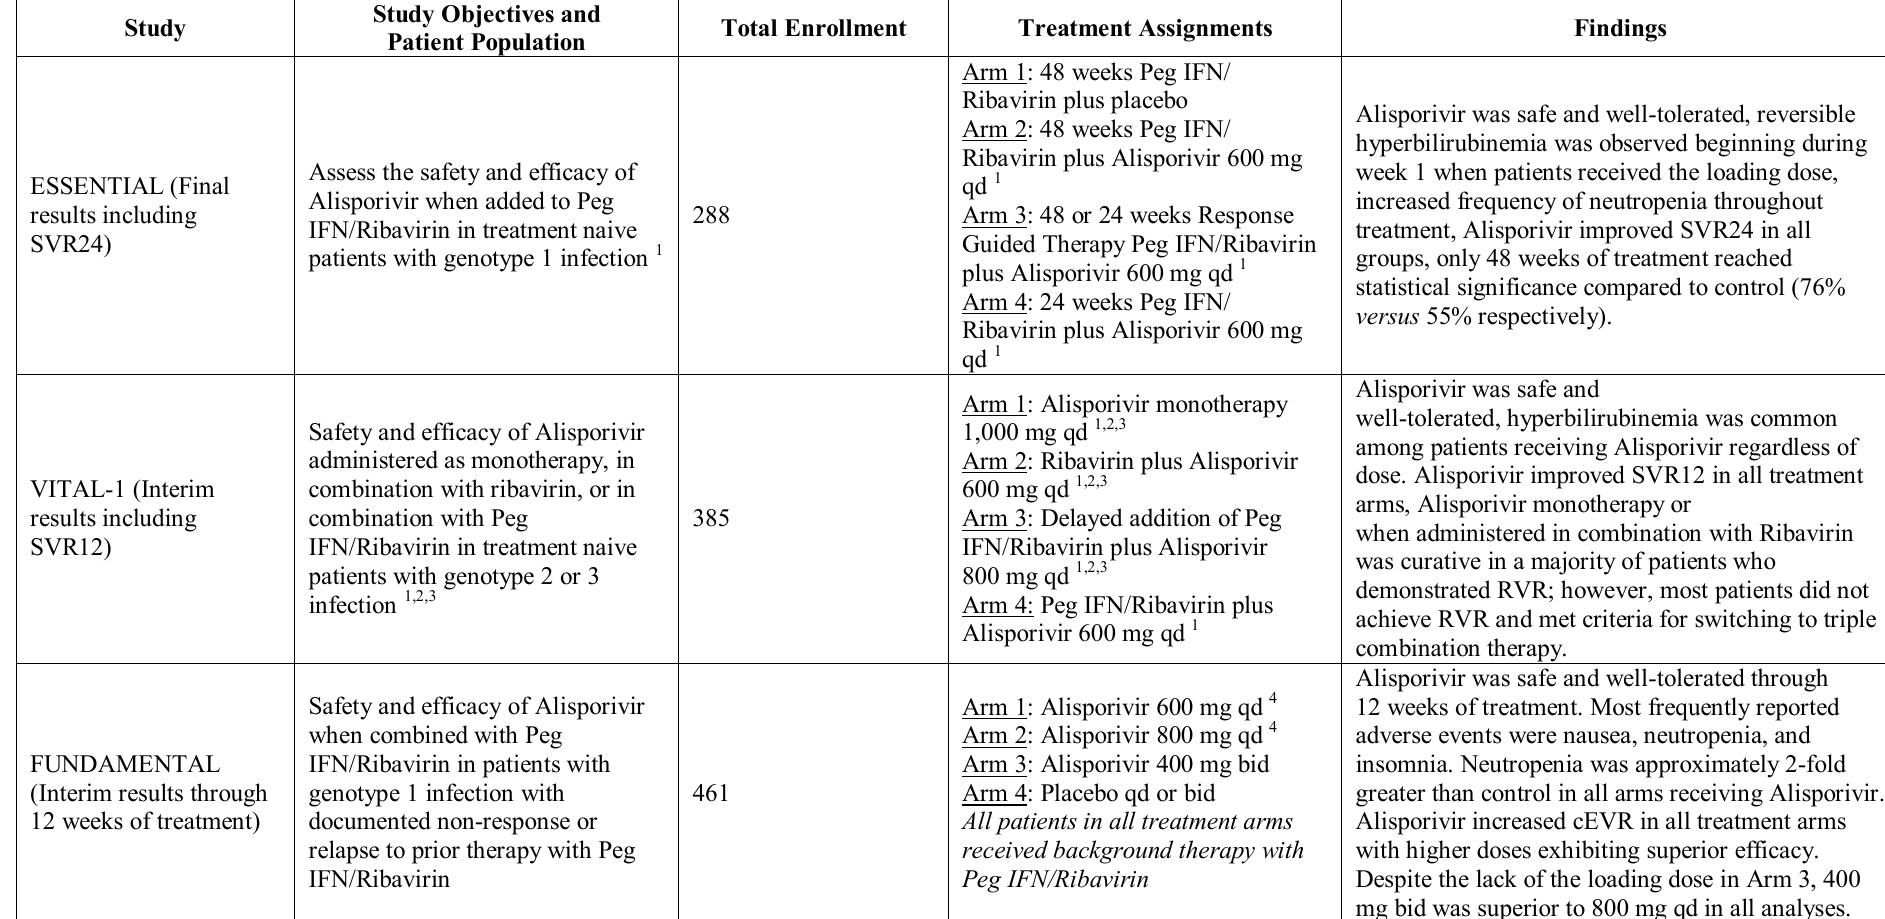
Table 1. Overview of the principal studies in the phase II development program for Alisporivir.